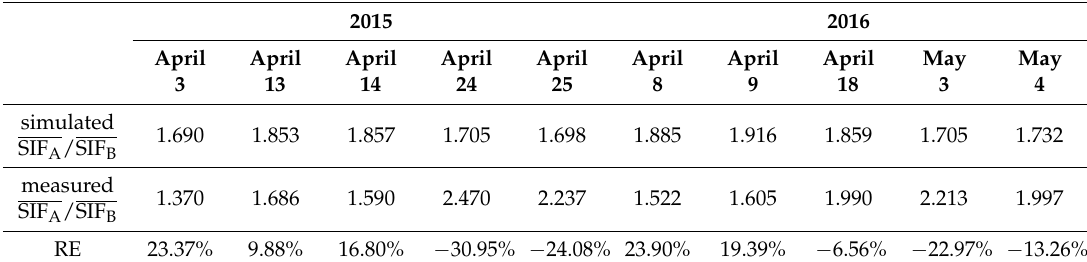
Table 5. The simulated and measured ratio of daily SIFA and SIFB averages, as well as the relative error (RE) between them with fixed FQE for ten fieldwork days in 2015 and